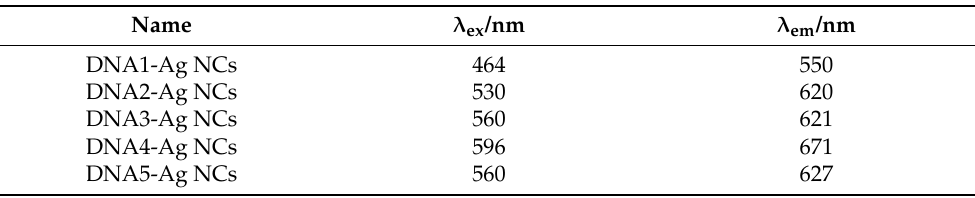
Table 2. Excitation and emission wavelengths of different DNA-Ag NCs.